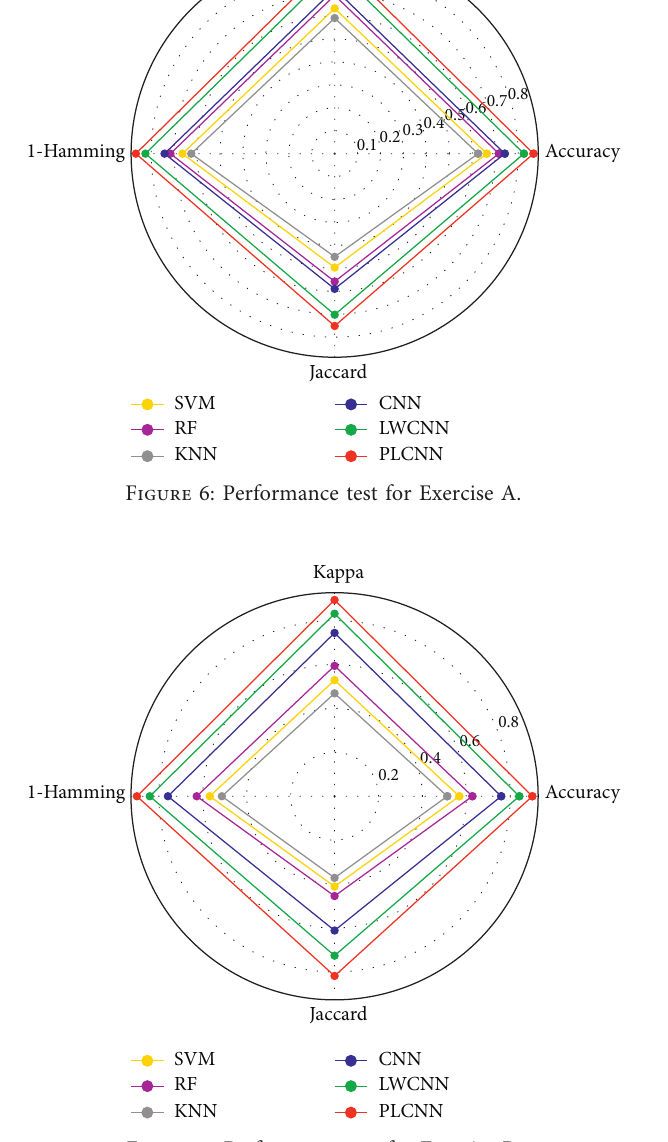
Figure 7: Performance test for Exercise B.